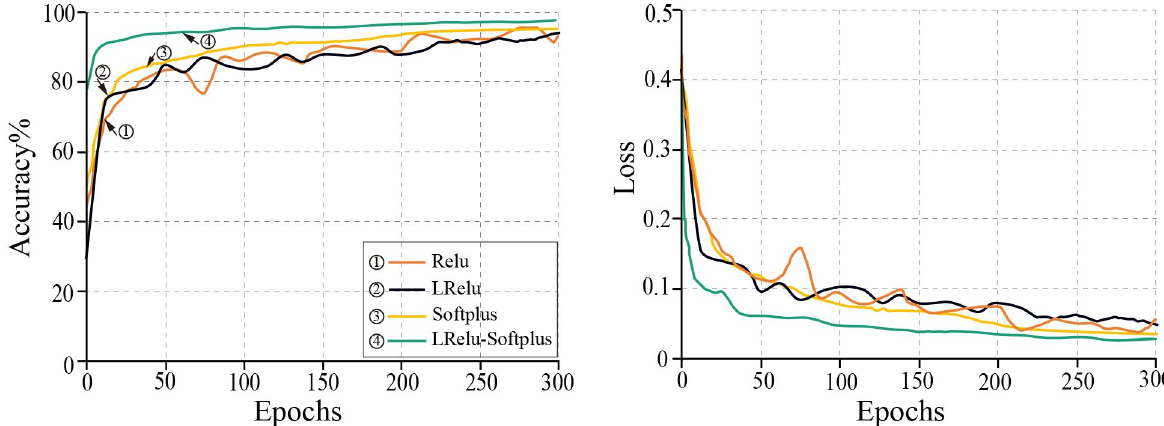
Fig 9. Effects of activation function on training accuracy and training